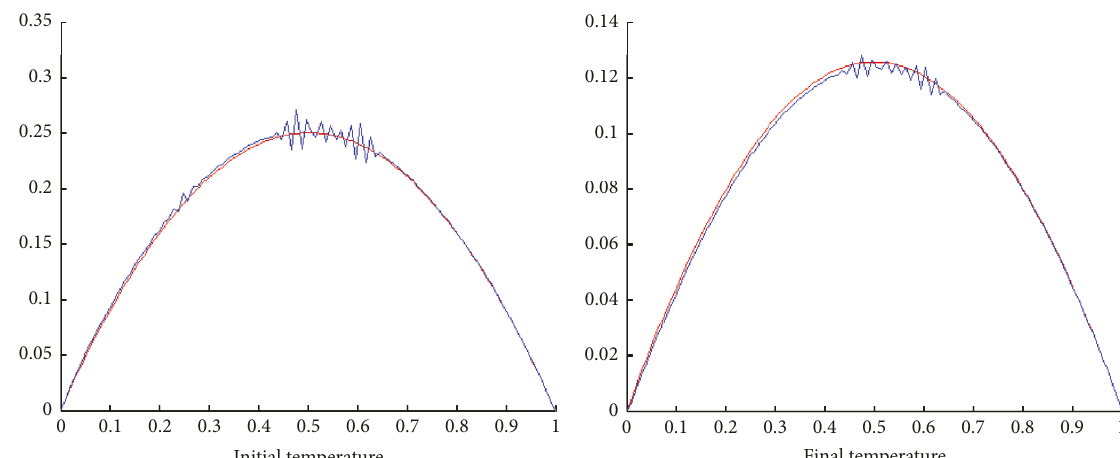
Figure 23: This figure shows that we can rebuild the